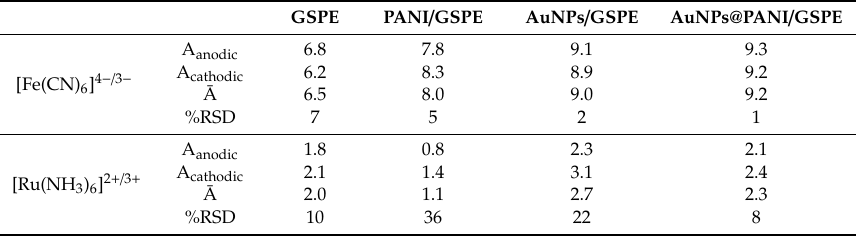
Table 1. Electroactive areas of di ff erent platforms (in mm 2 ), calculated from the CV scans performed in